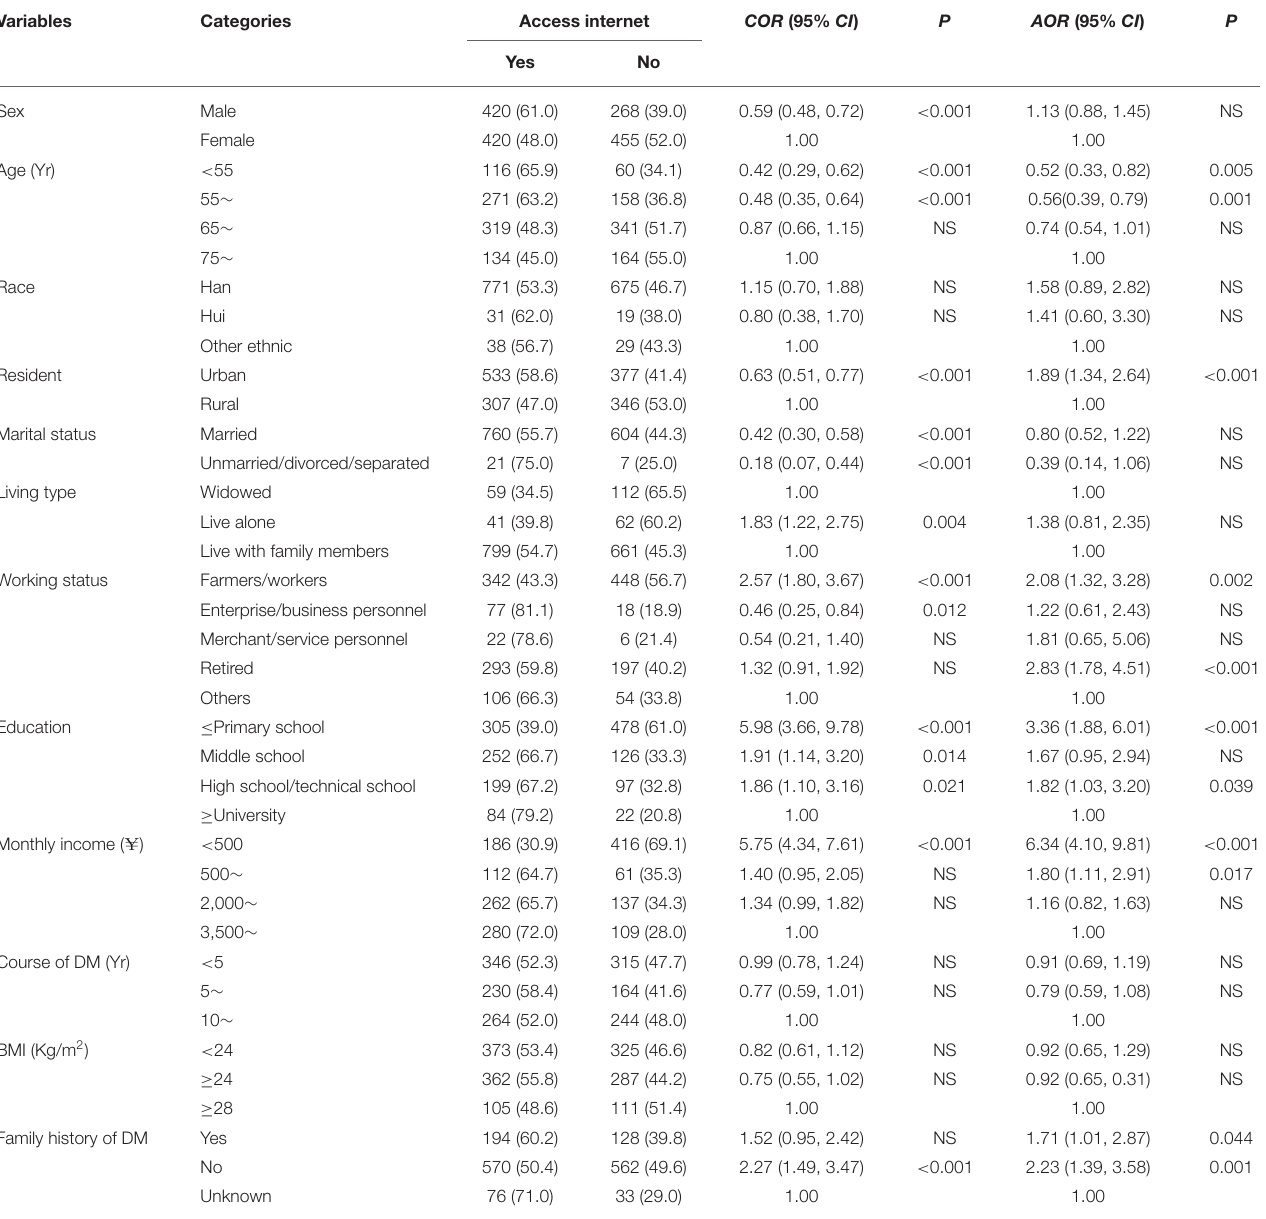
TABLE 2 | Bivariate and multivariate analyses of factors associated with the internet accessibility among the respondents [ n ,